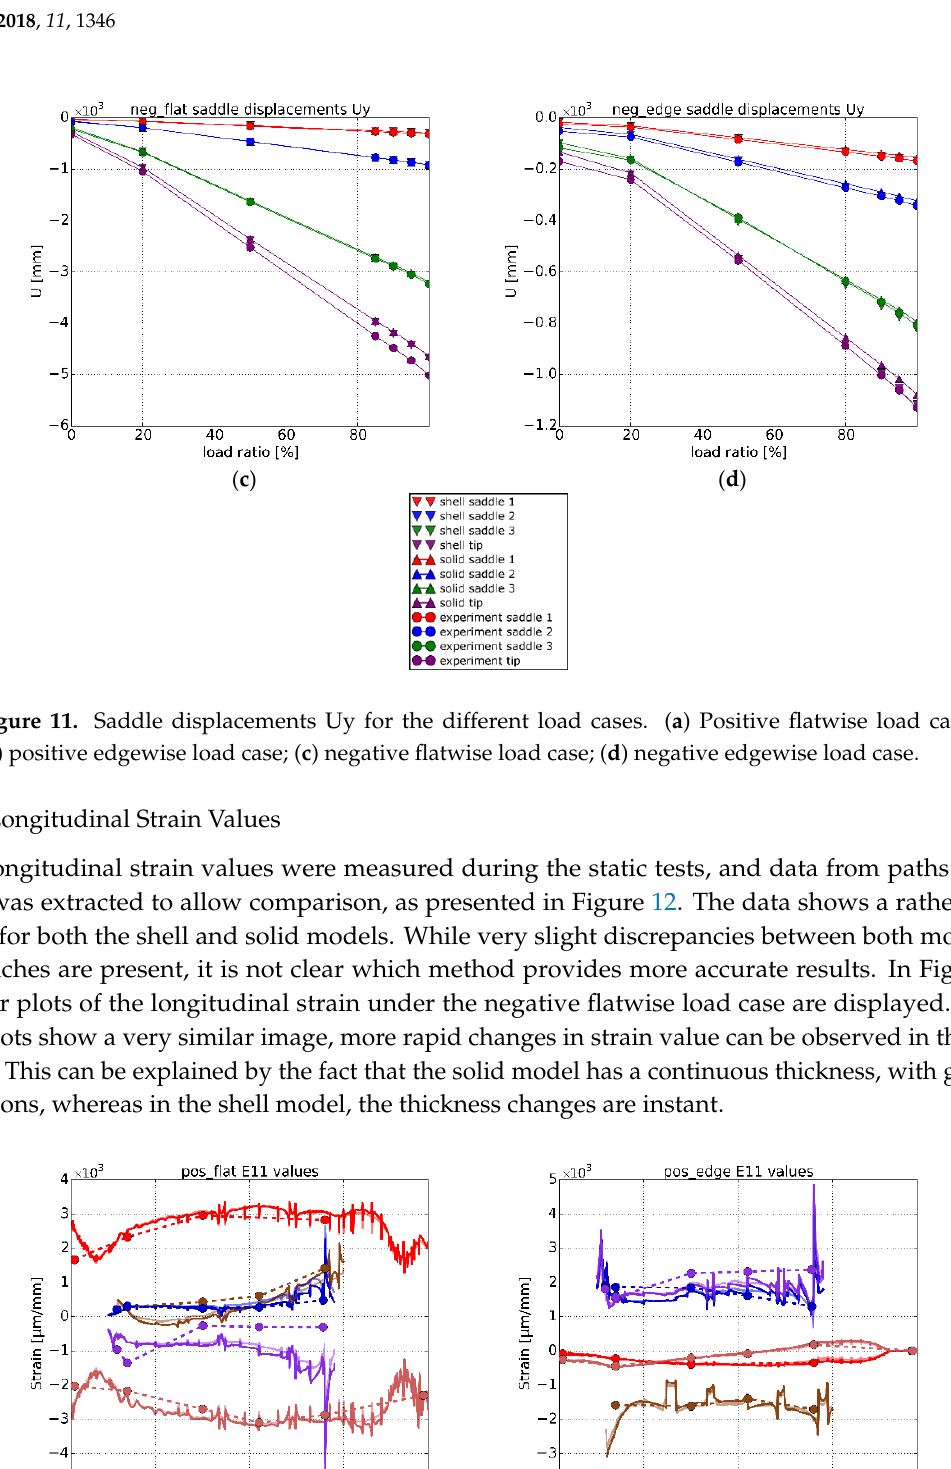
( d ) Figure 10. Saddle displacements Ux for the different load cases. ( a ) Positive flatwise load case; ( b ) positive edgewise load case; ( c ) negative flatwise load case; ( d ) negative edgewise load case.